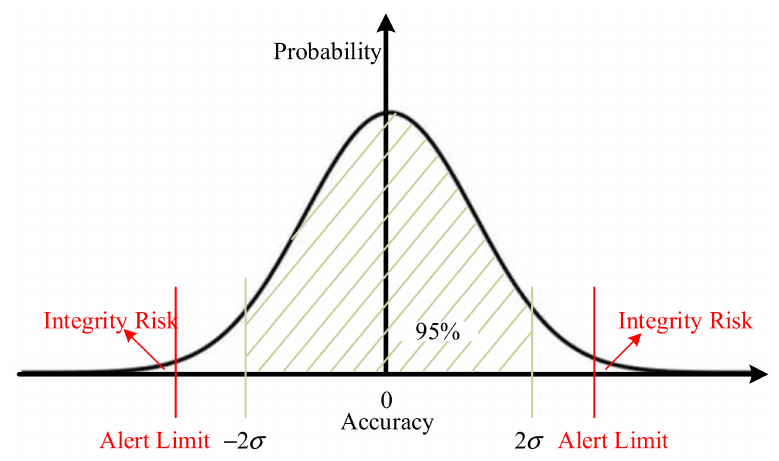
Figure 4. Relationship of integrity risk, alert limits and